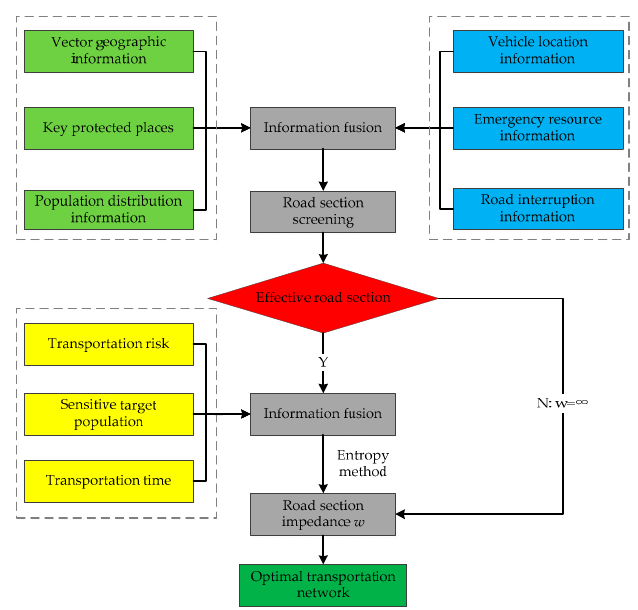
Figure 2. Algorithm flow chart for solving hazardous material optimal transportation network.